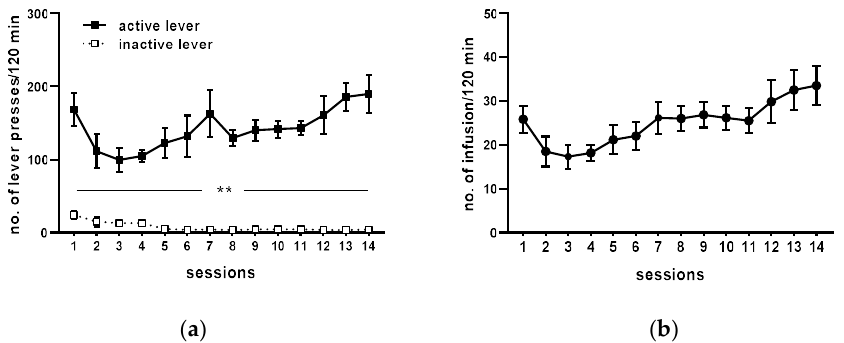
Table 1. Cocaine (0.5 mg/kg/infusion) self-administration. Presses on the levers and cocaine infusion.